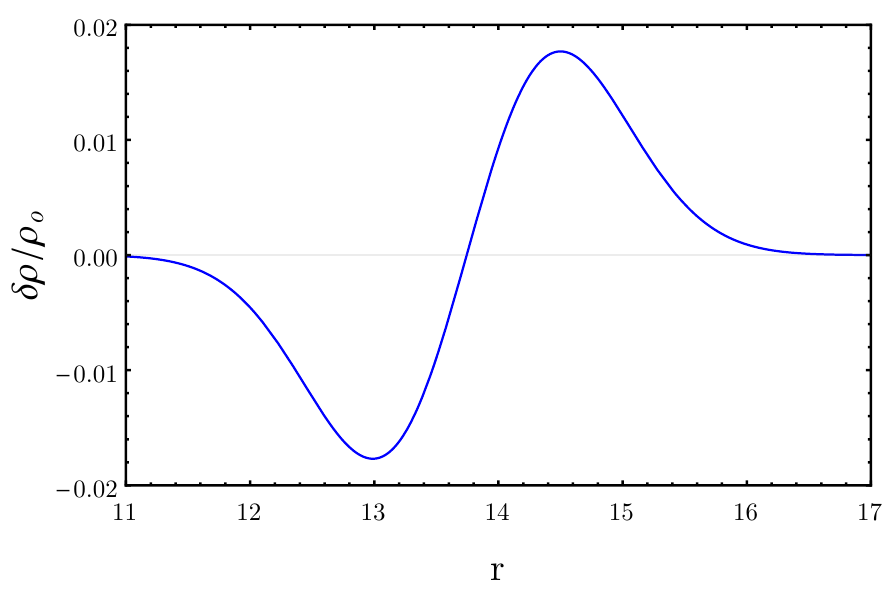
Figure 10 . Density profile of n = 1 large particle-hole excitation for ν = 1 / 3 . The overall factor 1 /R is fixed to the value of N = 64 electrons for comparison with the small excitation in figure